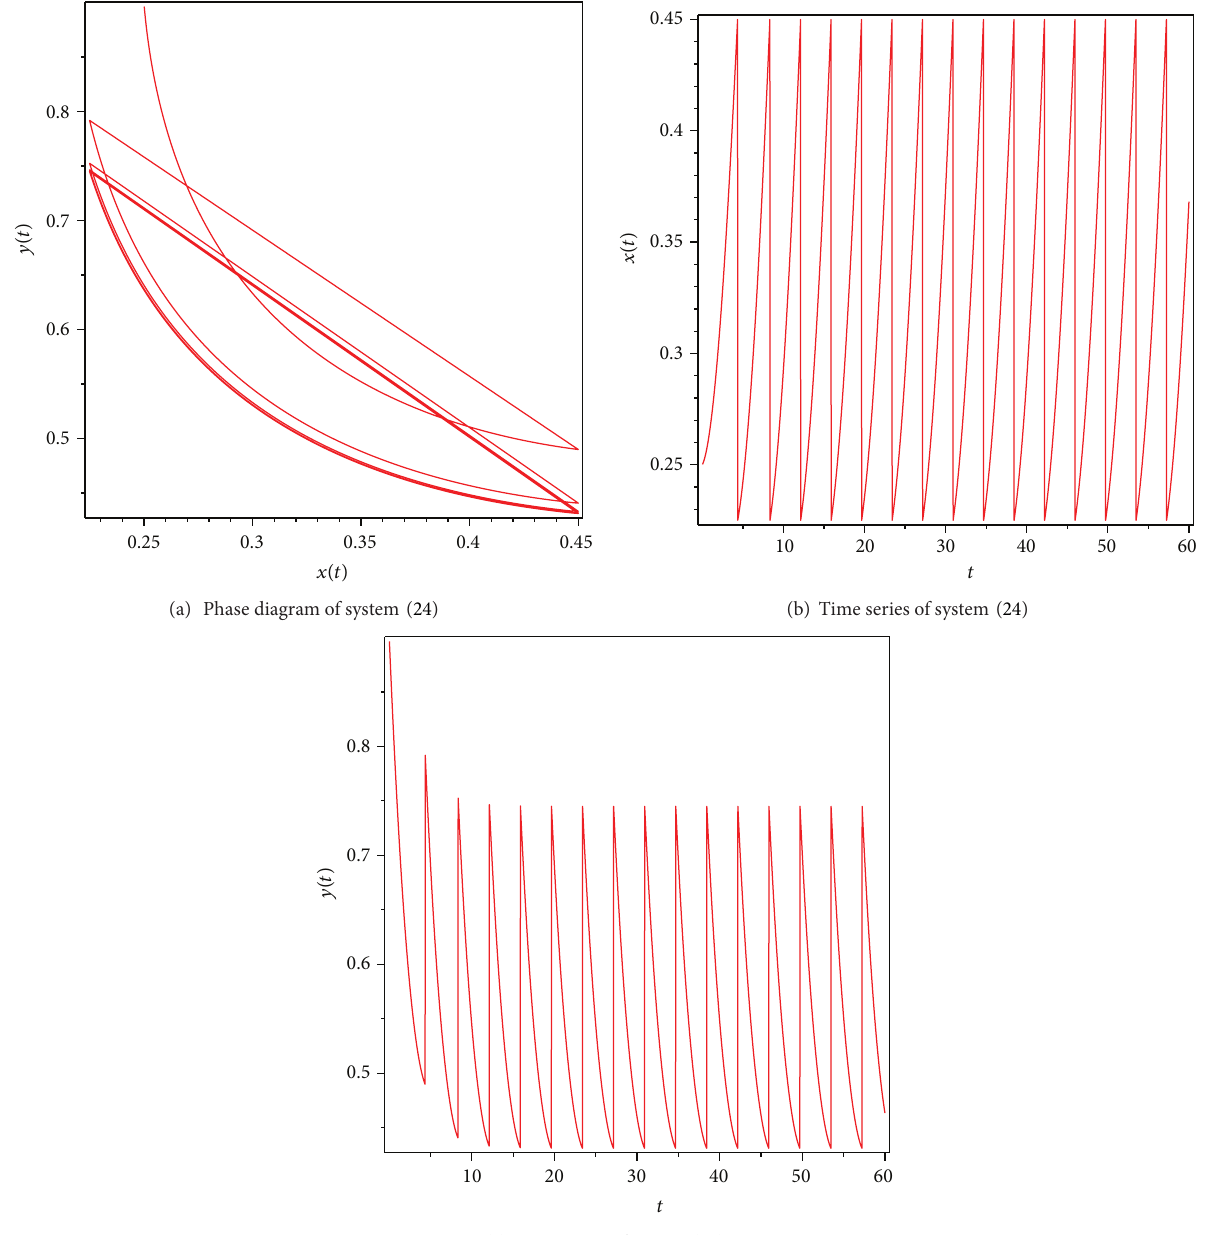
Figure 23: Illustration of basic behavior of system